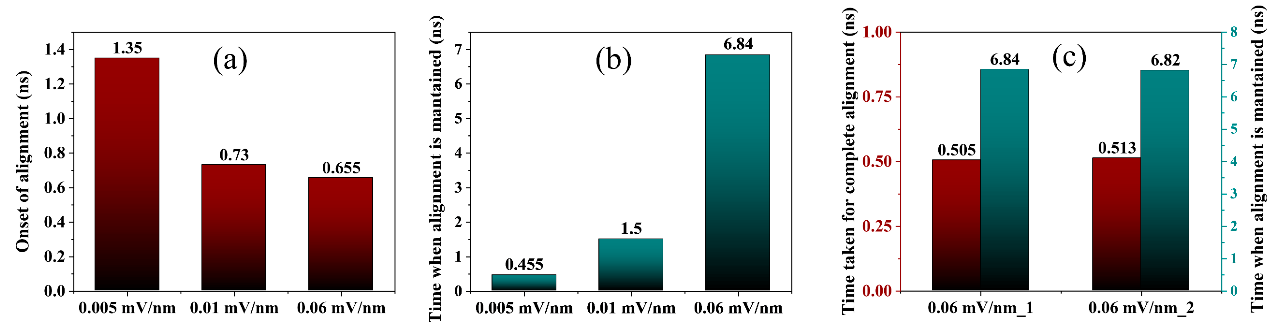
Figure 2. ( a ) Onset of cellulose alignment in the electric field, ( b ) the time when alignment in the electric field is maintained, and ( c ) the time taken to complete and maintain alignment at 0.06 mV/nm. The simulations were conducted twice to verify the reproducibility of these